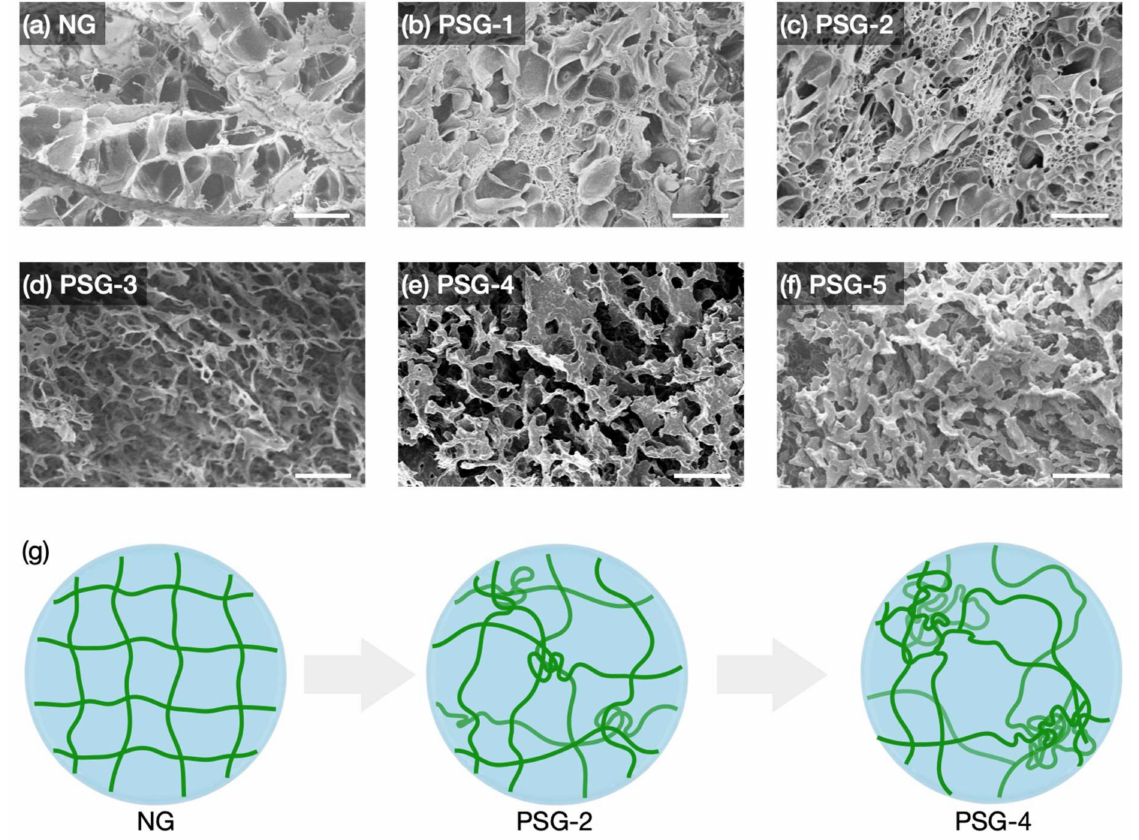
Figure 5. ( a – f ) SEM images of NG and PSGs. Scale bar, 10 µ m. ( g ) Illustration of network structures according to degree of phase